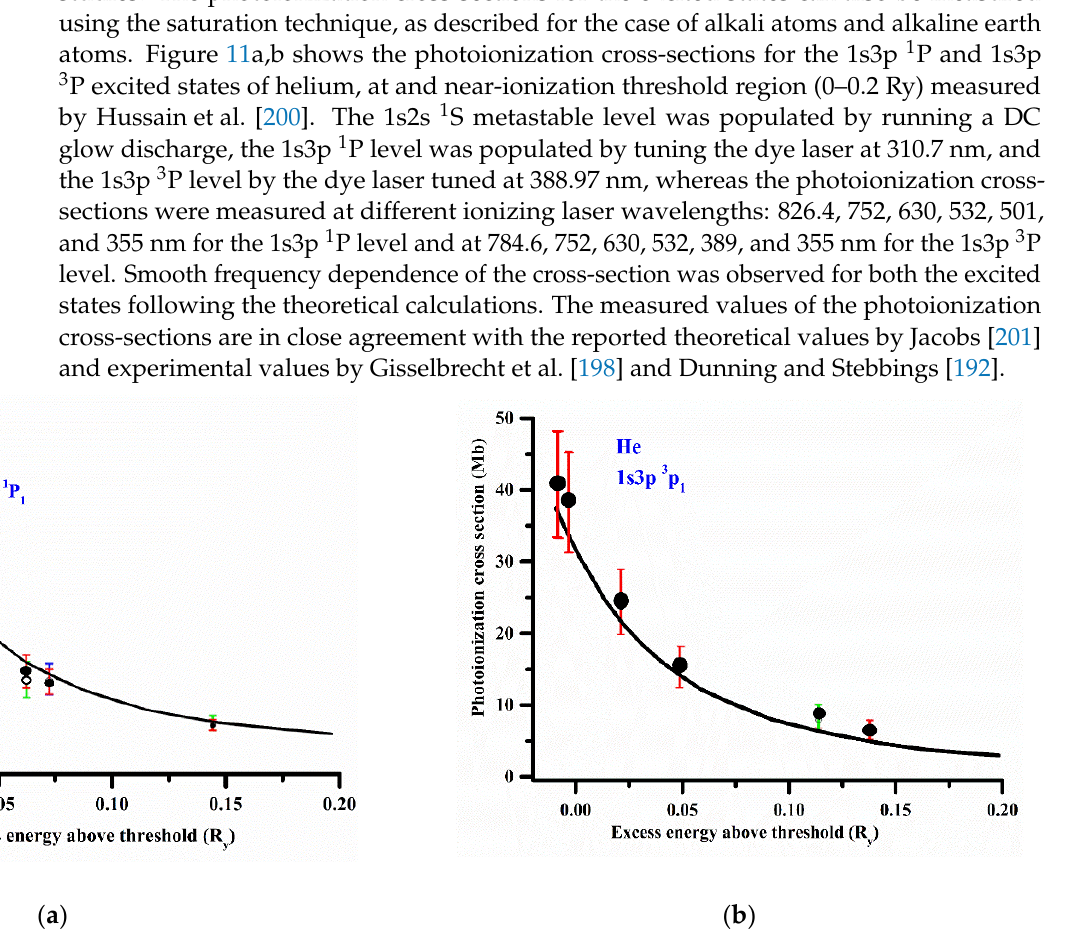
Figure 11. ( a , b ). Show the dependence of the photoionization cross-sections for the 1s3p 1 P and